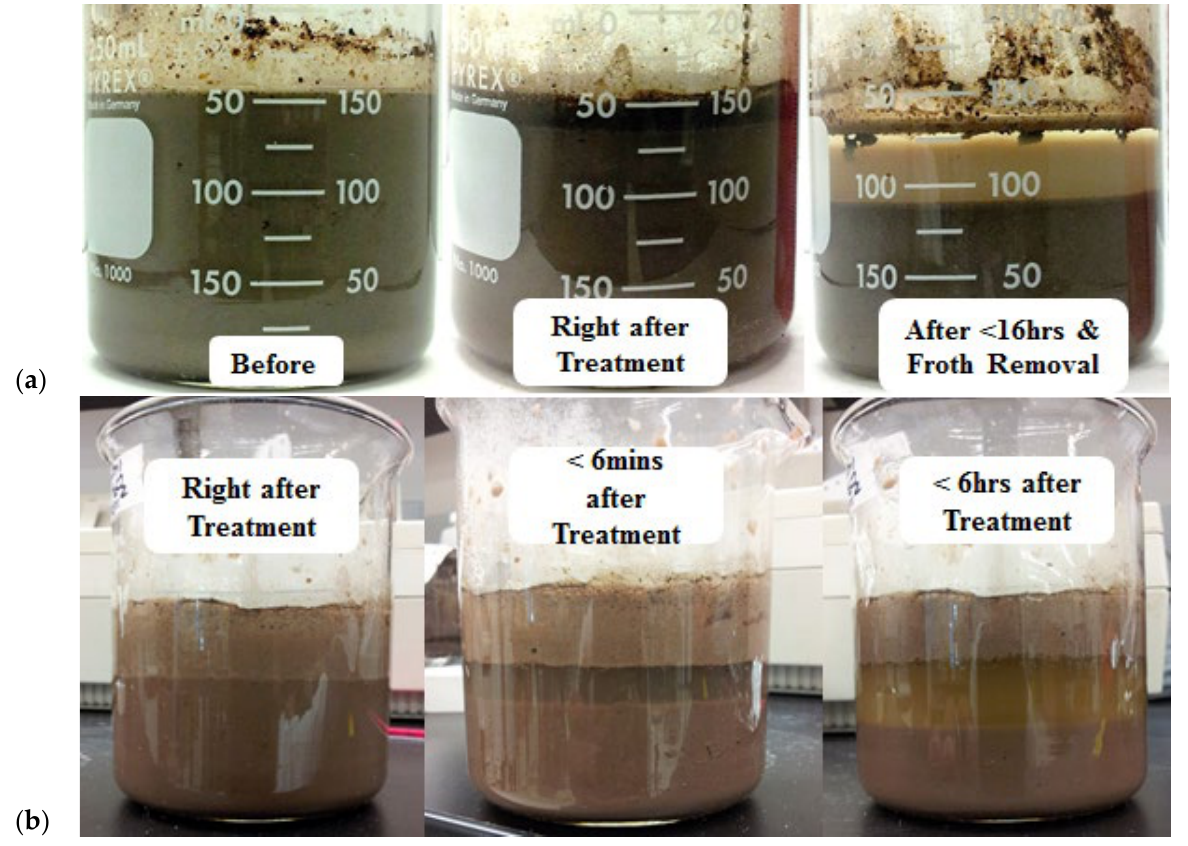
Figure 1. Effect of temperature, pressure, and oxidant on ( a ) 25% ( v / v ) MFT slurry at 200 °C and 3.4 MPa for 15 min and ( b ) 25% ( v / v ) MFT slurry at 200 °C and 3.4 MPa for 5 min with the addition of H 2 O 2 .